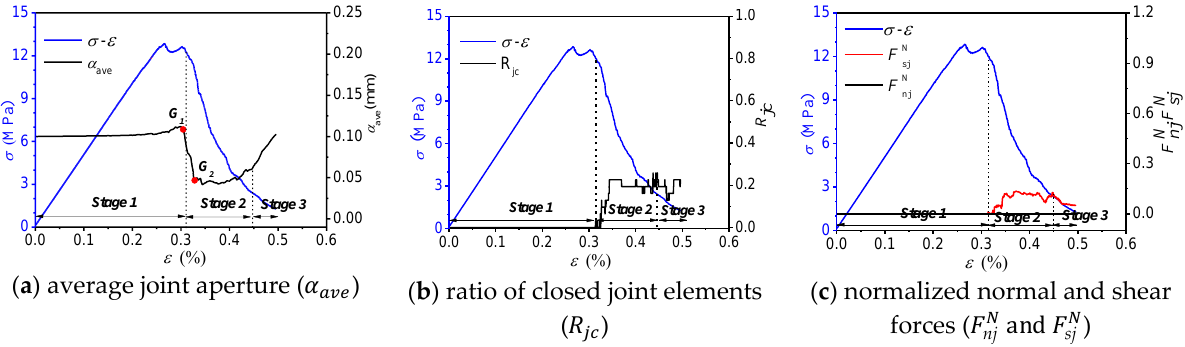
Figure 16. Evolution of force chain distribution with axial strain increases ( 𝛽 =60°).